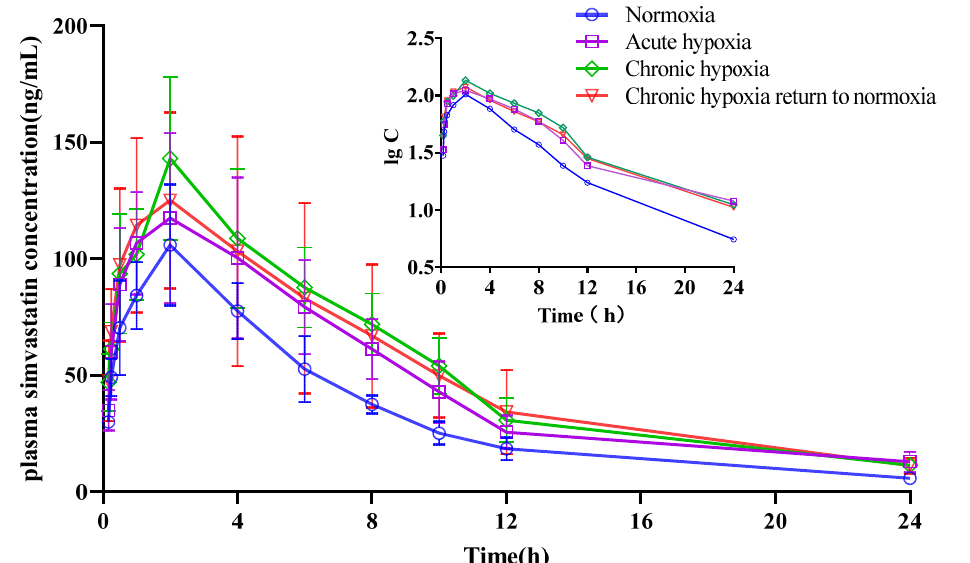
Figure 4. Mean plasma concentration time curve of simvastatin for rats after exposure to high-altitude hypoxia ( n = 8).